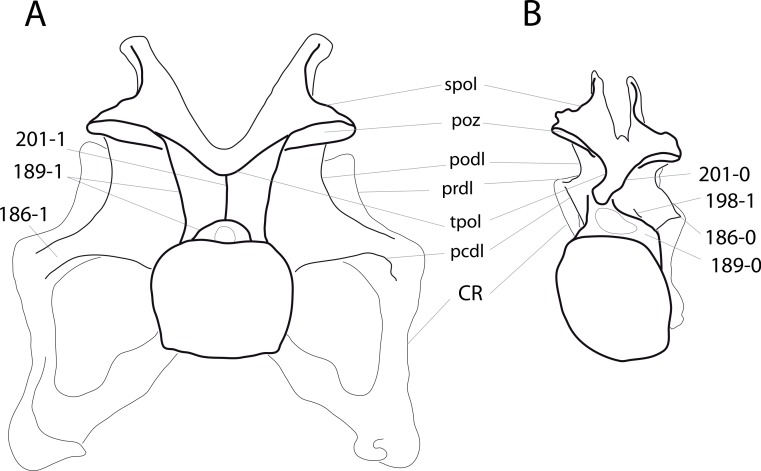
Cervical vertebra 12 of diplodocids.Cervical vertebra 12 of Apatosaurus louisae CM 3018 (A; based on Gilmore, 1936), and Kaatedocus siberi SMA 0004 (B; based on Tschopp & Mateus, 2013b) in posterior view. Note the separated (A; C186-1) or connected pcdl and podl (B; C186-0), the divided (A; C189-1) or single cpol (B; C189-0), the accessory lamina in the postzygapophyseal centrodiapophyseal fossa (B; C198-1), and the tpol that connects directly (B; C201-0) or indirectly with the neural canal roof (A; C201-1). Abb.: CR, cervical rib; pcdl, posterior centrodiapophyseal lamina; podl, postzygodiapophyseal lamina; poz, postzygapophysis; prdl, prezygodiapophyseal lamina; spol, spinopostzygapophyseal lamina; tpol, interpostzygapophyseal lamina. Scaled to the same posterior cotyle height.